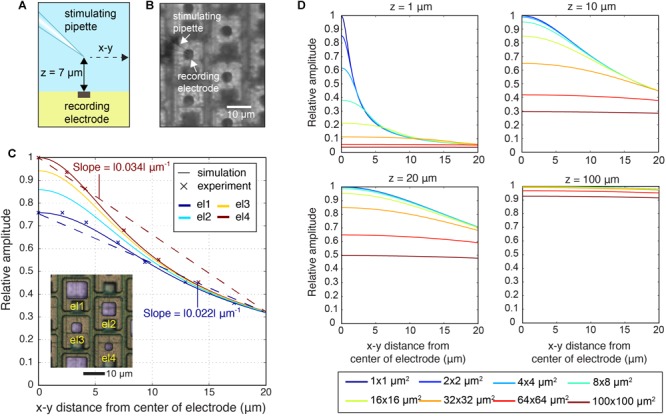
Spatial-averaging of a point-source signal by the electrodes. (A) Schematic side view of the experiment, where the stimulating pipette constituted the known point-current source at a z-distance of 7 μm above the electrode array. The pipette was kept at the same z-distance during lateral movements of 20 μm parallel to the surface in the x–y plane. (B) Differential interference contrast (DIC) microscopy image of the electrode array showing el4 (11 μm2) electrodes and the stimulating pipette. (C) Simulation of the signal amplitudes of four electrode sizes (el1: 86 μm2; el2: 44 μm2; el3: 22 μm2; el4: 11 μm2) and experimental recordings of signal amplitudes of two electrode sizes (el1: 86 μm2; el4: 11 μm2), measured while the pipette was moved in the x–y plane at a z-distance of 7 μm above the electrode array in saline. Amplitudes were normalized to the maximum signal amplitudes detected. The inset image shows bright Pt electrodes of four different sizes (el1–el4). (D) Simulation of relative detectable signal amplitudes upon increasing the z-distance (z = 1, 10, 20, 100 μm2) and for varying the electrode size (1 × 1, 2 × 2, 4 × 4, 8 × 8, 16 × 16, 32 × 32, 64 × 64, 100 × 100 μm2). The largest obtained signal was set to one.